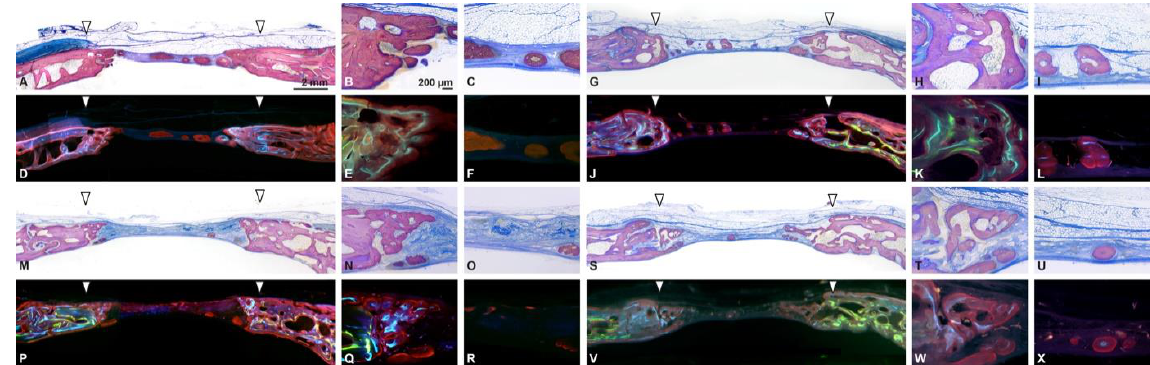
Figure 6. Histological view of the defect (sagittal plane) in CM ( A – F ), mCM ( G – L ), CM/M ( M – R ) and mCM/M groups ( S – X ). Overviews ( A , M , G , S ) and magnified views ( B , C , N , O , H , I , T , U ) stained with Toluidine blue and Fuchsin. Overviews ( D , P , J , V ) and magnified views ( E , F , Q , R , K , L , W , X ) of the merged bone labeling (0w; labeled with calcein in green, 6 w; tetracycline, light blue, 12 w; alizarin, red).